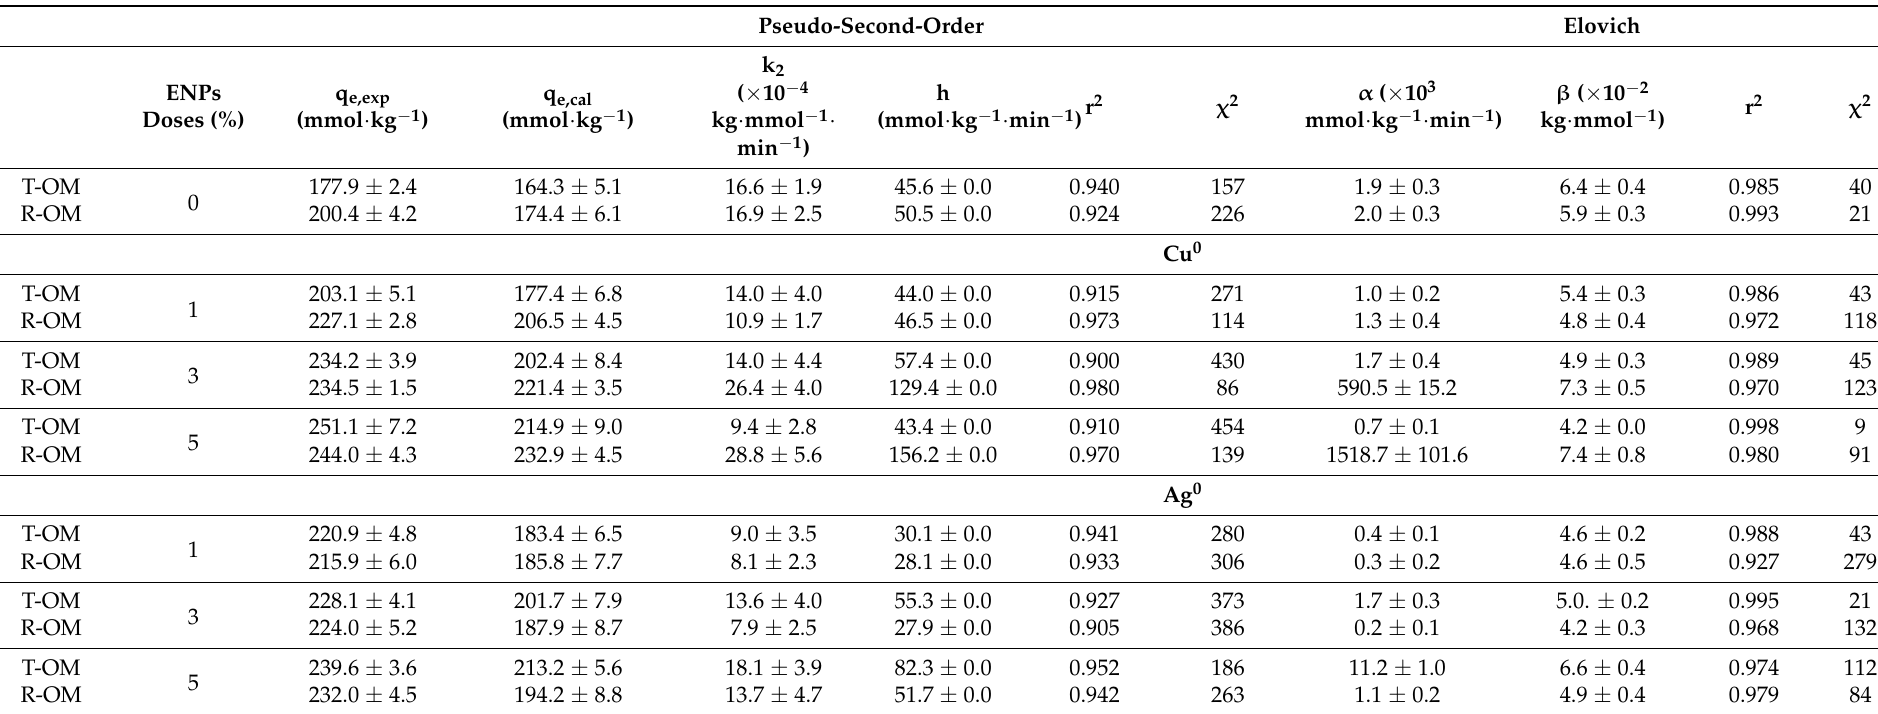
Table 5. Pseudo-second-order and Elovich parameters ( ± standard error) obtained from H 2 PO 4 − adsorption kinetics at pH 5.5 ± 0.2 for the soil with total organic matter (T-OM) and with partial removal of organic matter (R-OM) in the absence and presence of different doses of Cu 0 or Ag 0